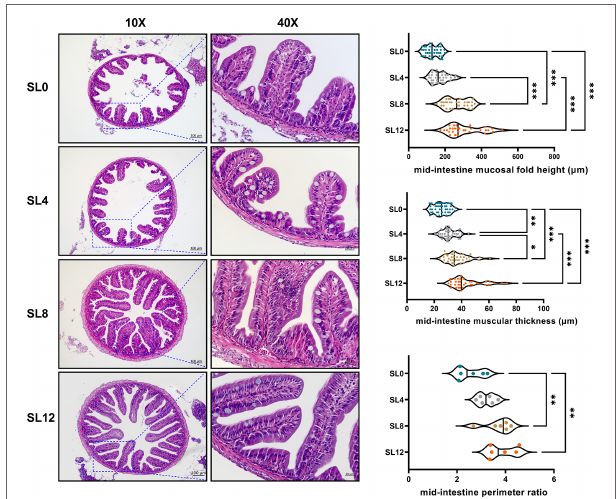
FIGURE 2 | Longitudinal paraffin section of the mid-intestine. A total of 24 slices with 6 slices per treatment were observed. The perimeter ratio, intestinal muscular thickness, and mucosal fold height are presented by a violin plot. * P < 0.05, ** P < 0.01, *** P < 0.001; otherwise, no significant difference( P >